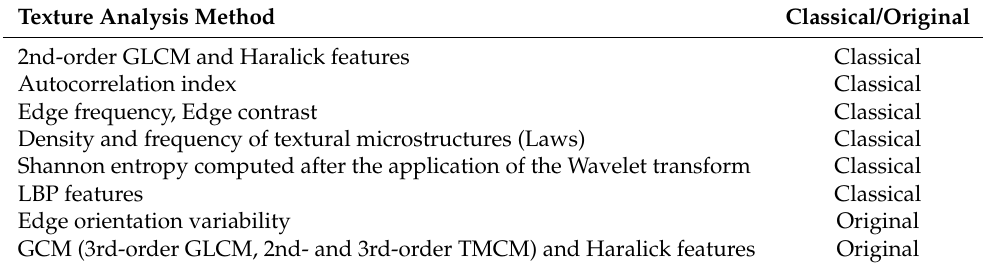
Table 3. The texture analysis methods involved in our